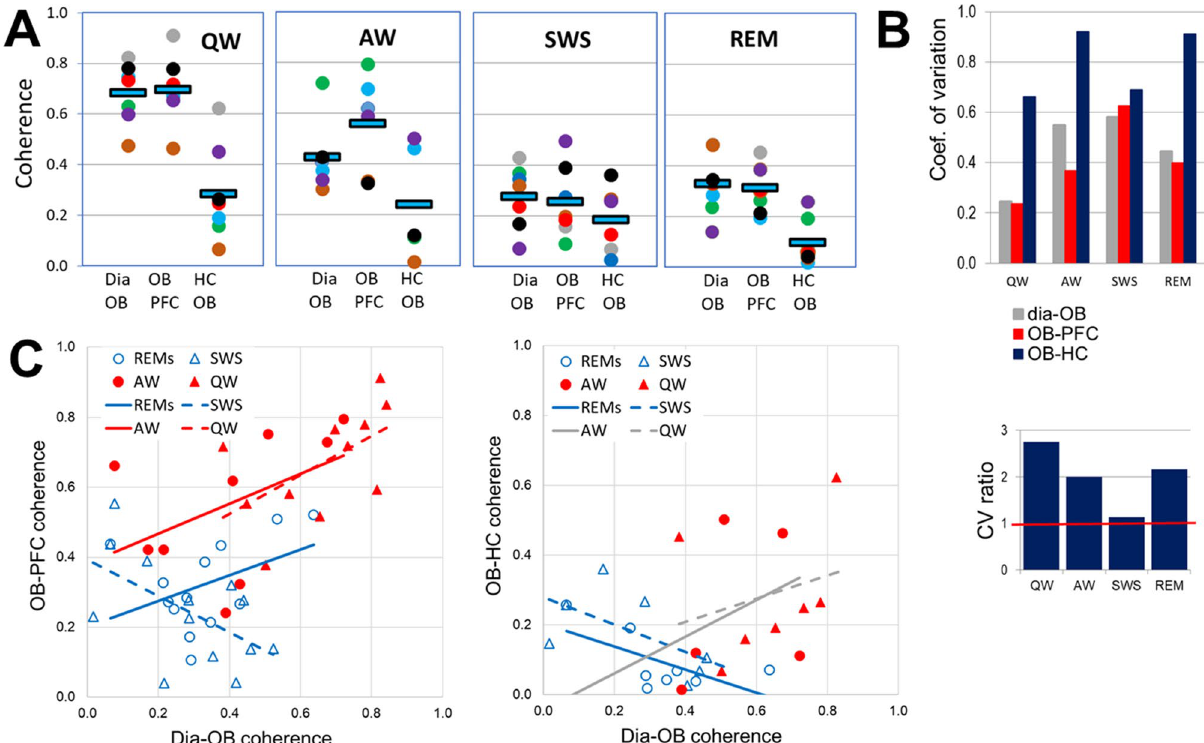
Figure 2. Comparison of state-dependent RRO coherences in PFC and HC transferred through OB. ( A) Pair-wise coherences at the respiratory frequency (RRO) between rhythmic dia activity and LFP in the OB and between OB and cortical (PFC) and hippocampal (HC) networks during different sleep–wake states. Note strong state dependence and nearly identical dia-OB and OB-PFC coherences in all recordings and considerably lower OB-HC coherence. Squares: group averages, dots: individual experiments; same colors identify individual rats across different states. ( B) Variability of coherence values in individual experiments in different states. Coefficient of variation (top) and CV ratio (bottom) of coherences in the OB-HC vs. the other two signal pairs (dia-OB and OB-PFC). Note high variation of OB-HC in waking (AW and QW) and REM sleep, 2–3 times exceeding CV of the other pairs. ( C) Relationship between RRO coherences connecting dia to OB C(Dia-OB) and those connecting OB to neural networks of PFC (left) and HC (right) in different states. Trend lines with nonsignificant correlations (p > 0.1) are shown in gray; solid lines show theta, and dashed lines show non-theta states. Note the significant positive correlation between dia-OB and OB-PFC but no positive correlation between dia-OB and OB-HC coherences (only a non-significant trend in waking).